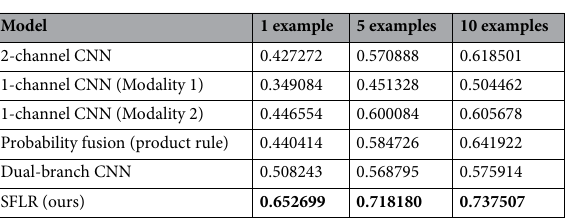
Table 1. Few-shot learning sensor fusion classification results ( F 1 macro) for Human Activity Recognition. Best results are shown in